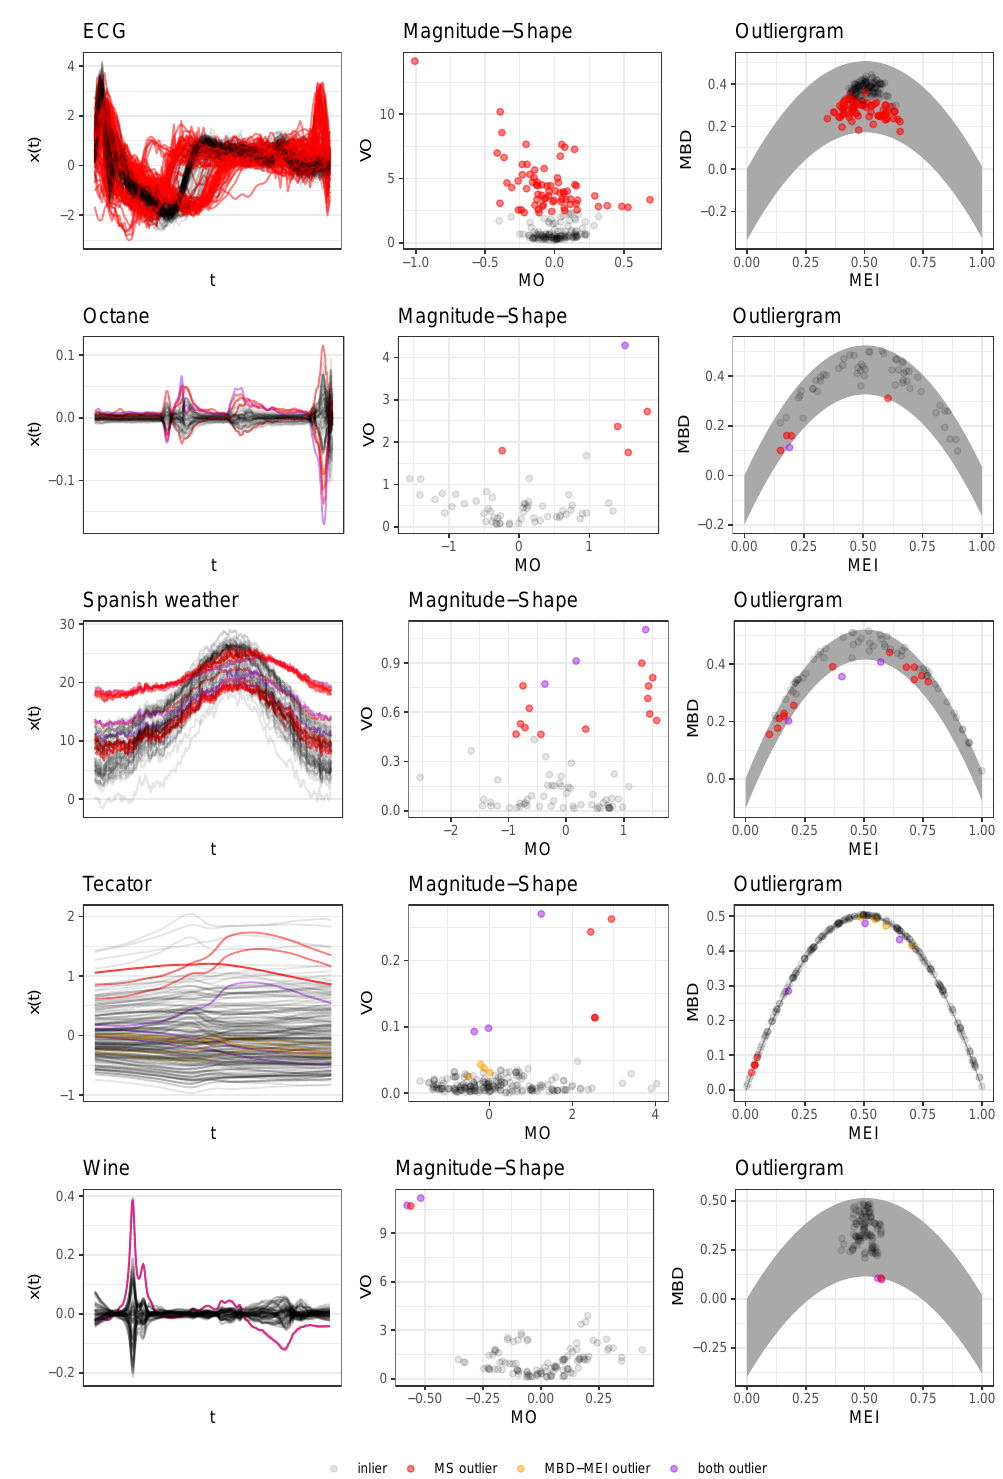
Figure A5. Left column: data; middle column: magnitude–shape plots of mean directional out- lyingness (MO) versus variability of directional outlyingness (VO); right column: outliergram of the modified epigraph index (MEI) versus modified band depth (MBD) with the inlier region in grey. Curves and points are colored according to outlier status as diagnosed by fdaoutlier::msplot and/or roahd::outliergram